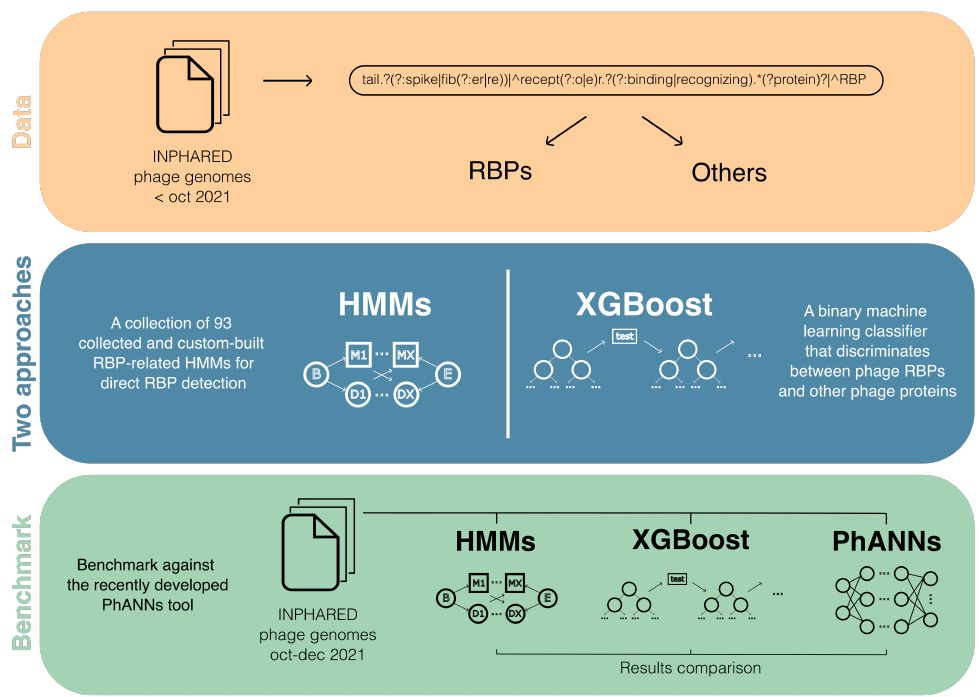
Figure 7. Dual identification of novel phage receptor-binding proteins. Graphical abstract of the collected phage genome data, the developed RBP detection tools and the benchmark against the recently developed PhANNs tool